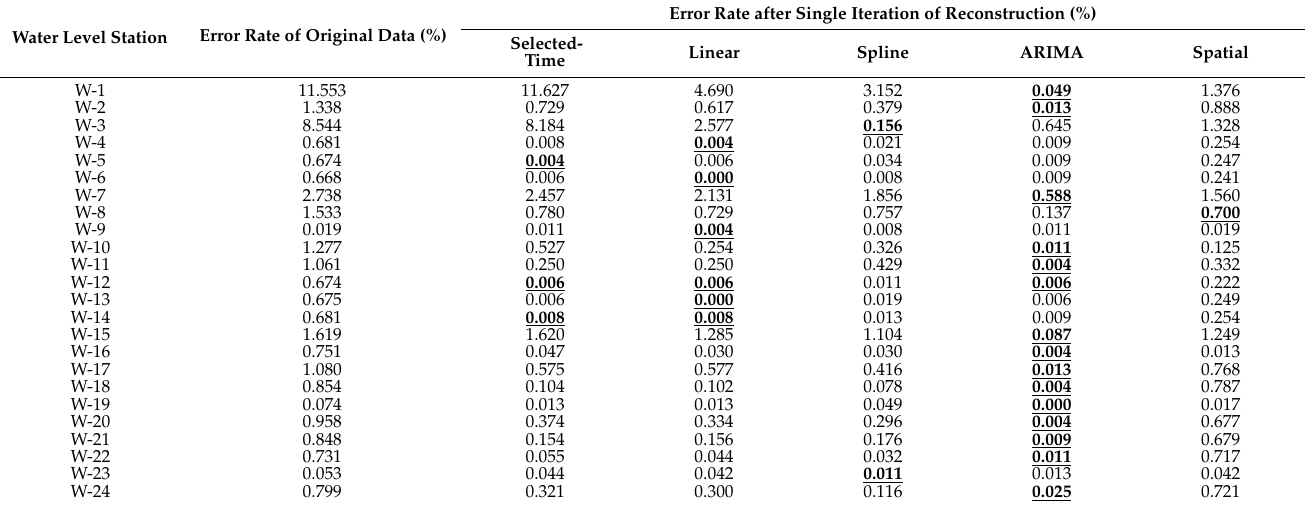
Table 9. Error rate comparison of five reconstruction methods in 24 water level stations. Water Level